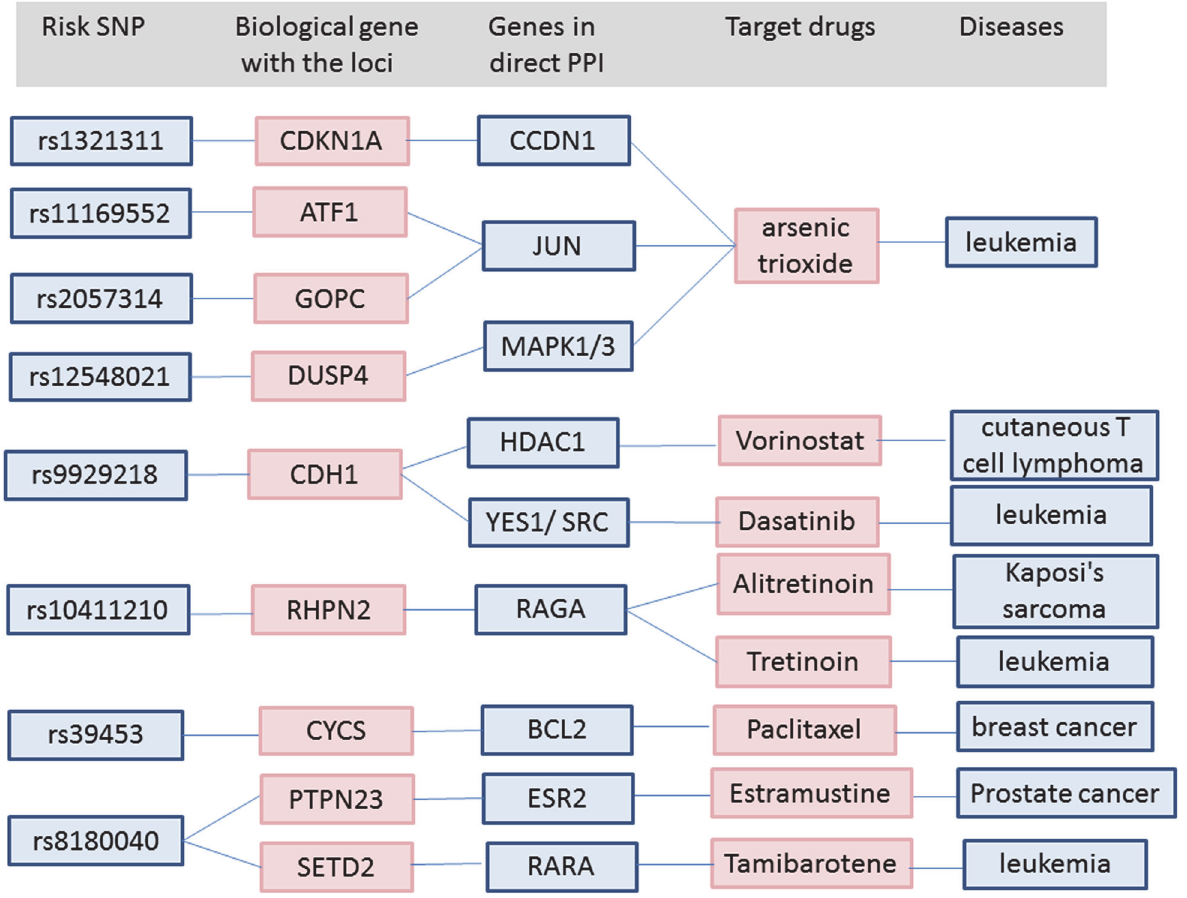
Fig 4. Detailed summary of the connections between risk SNPs, biological candidate genes from each risk locus, genes from the PPI network and drugs indicated for other